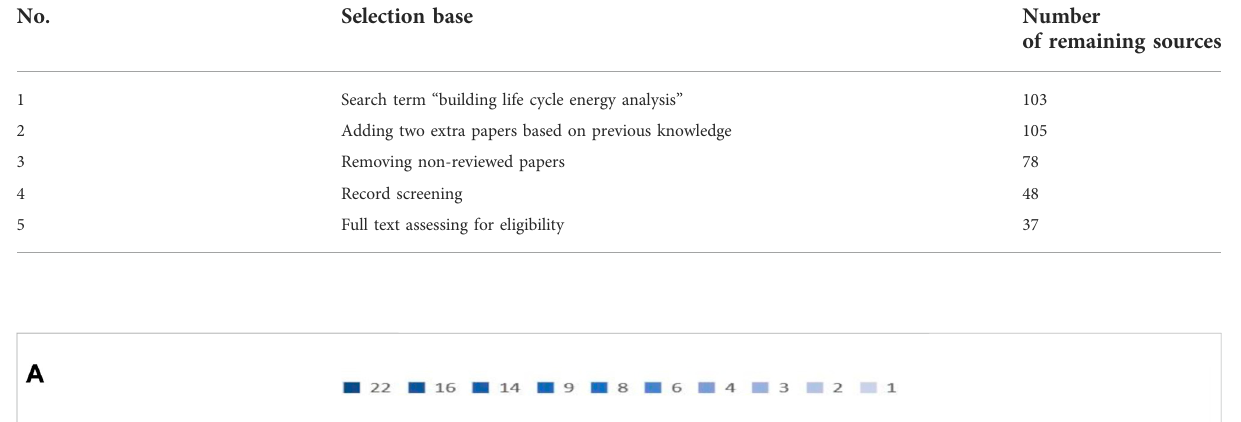
TABLE 1 Selection of material process.